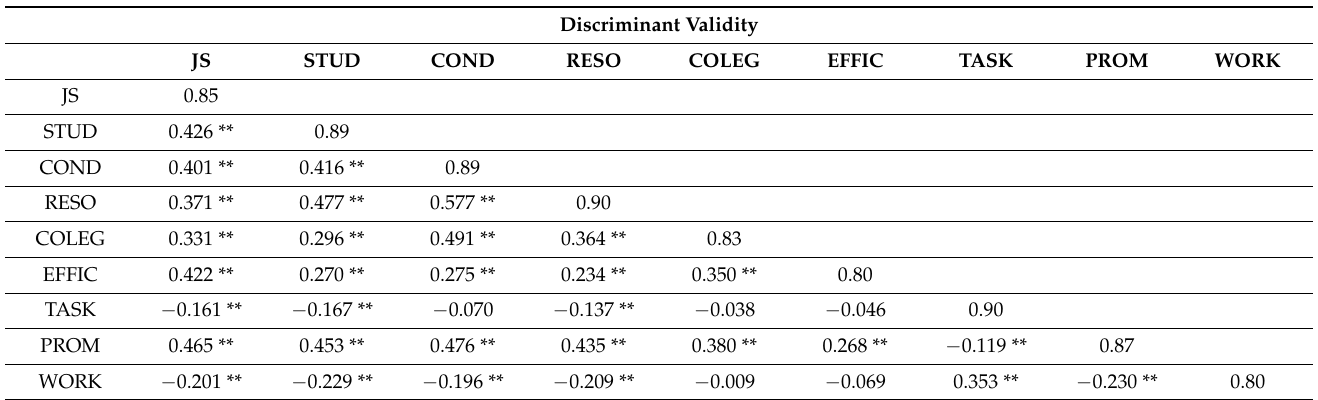
Table 4. Discriminant